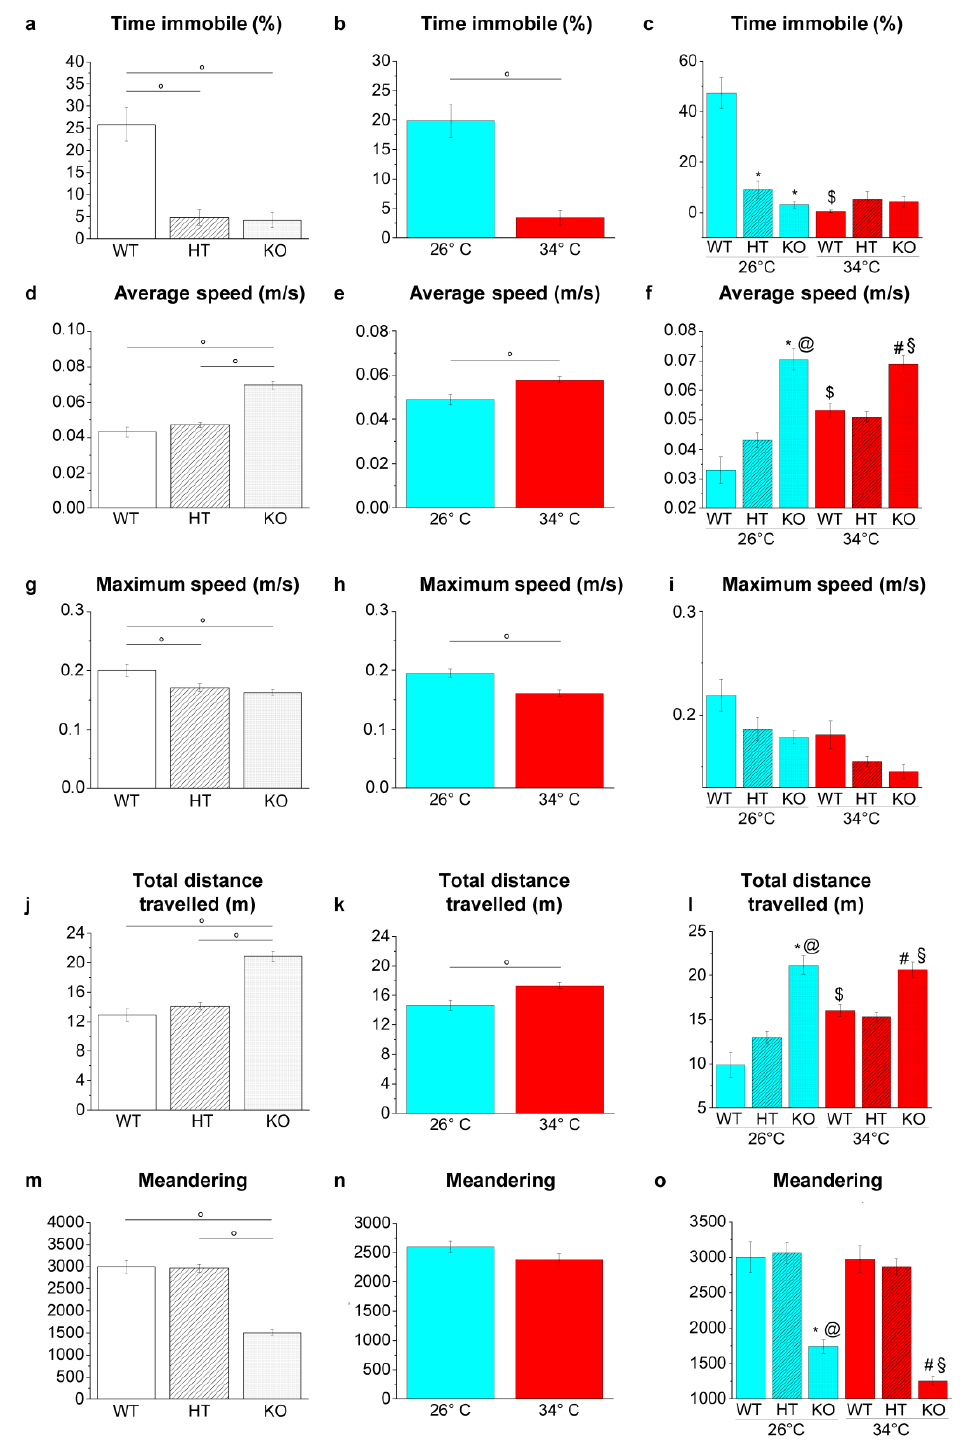
Figure 8. Swimming behaviour and locomotor activities in YMT. ( a – c ) Time immobile expressed as percentage of total time; ( d – f ) average speed; ( g – i ) maximum speed, ( j – l ) total distance travelled; ( m – o ) meandering. The data are expressed as means ± S.E.M. and analysed by two-way ANOVA with Bonferroni post hoc correction. p ≤ 0.05, °; *, HT26 vs. WT26 or KO26 vs. WT26; @, KO26 vs. HT26; #, HT34 vs. WT34 or KO34 vs. WT34; §, KO34 vs. HT34; $, WT34 vs. WT26, HT34 vs. HT26 or KO34 vs. KO26. p values and symbols used in the figure are shown in Table S21. N = 14. Blue and red colours refer to 26 °C and 34 °C, respectively.